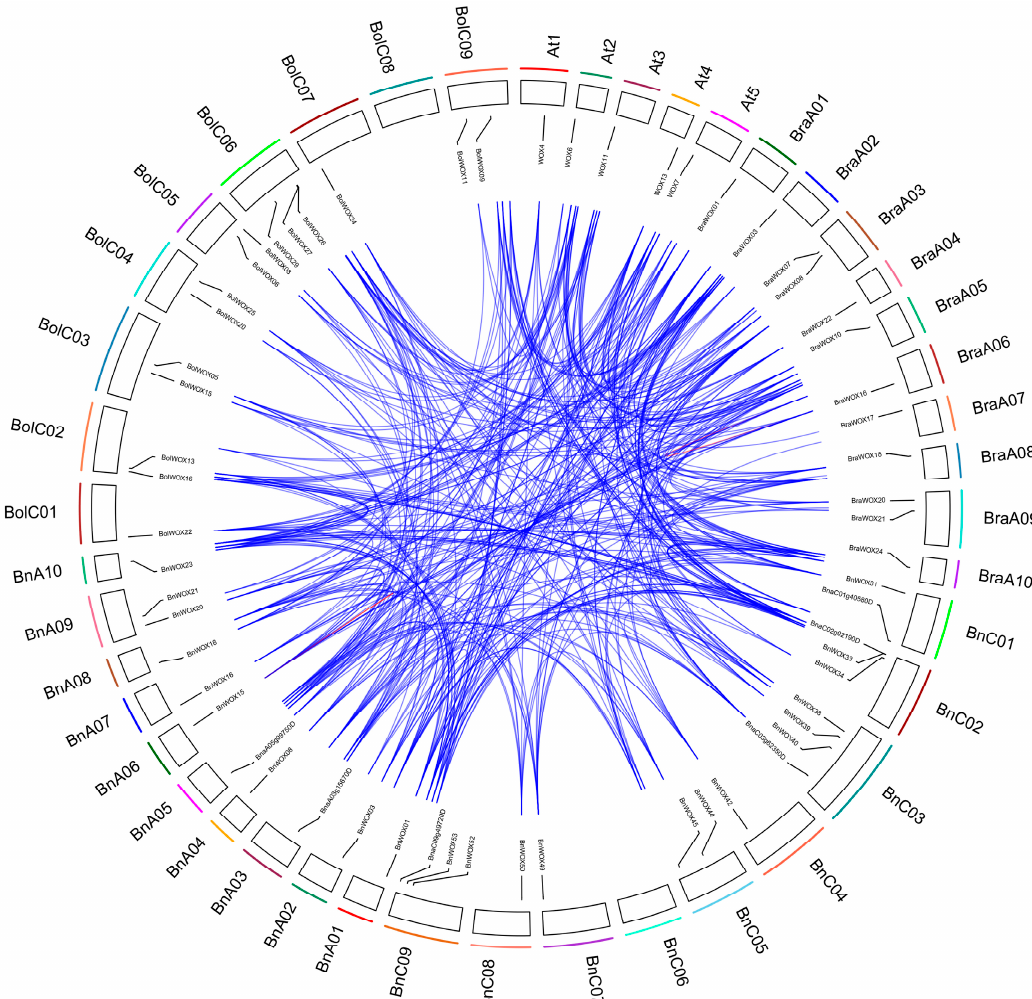
Figure 4. Collinearity analysis of WOX genes from Arabidopsis , B. rapa , B. oleracea and B. napus. The outer circle indicates the chromosome numbers and the inner circle indicates the location of AtWOX s, BnWOX s, BrWOX s and BoWOX s on the chromosomes. The blue lines link two syntenic WOX genes from B. napus , Arabidopsis , B. rapa and B. oleracea. The red line indicates a tandem duplication.